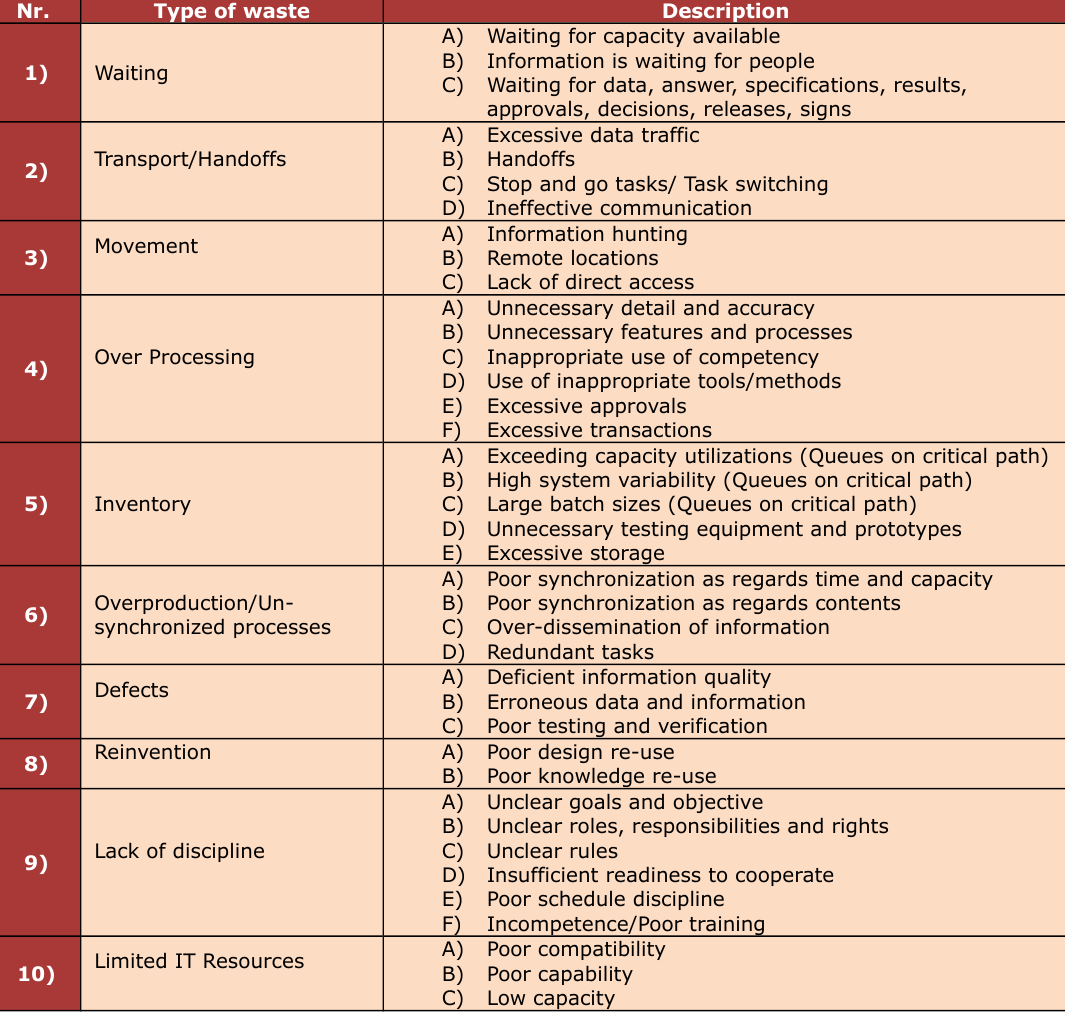
Table 1. Waste categories (Bauch,